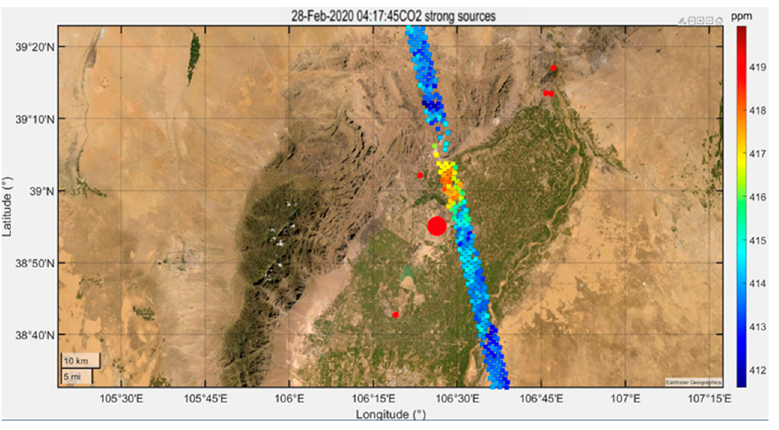
Figure 5. Measurement trajectory.